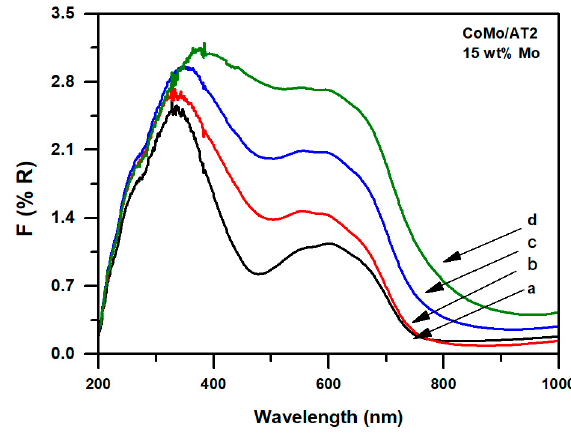
Figure 8. DR UV-vis spectra of the CoMo supported catalysts calcined at 673 K at different Co/(Co + Mo) ratios: ( a ) 0.1, ( b ) 0.2, ( c ) 0.3, and ( d ) 0.4.